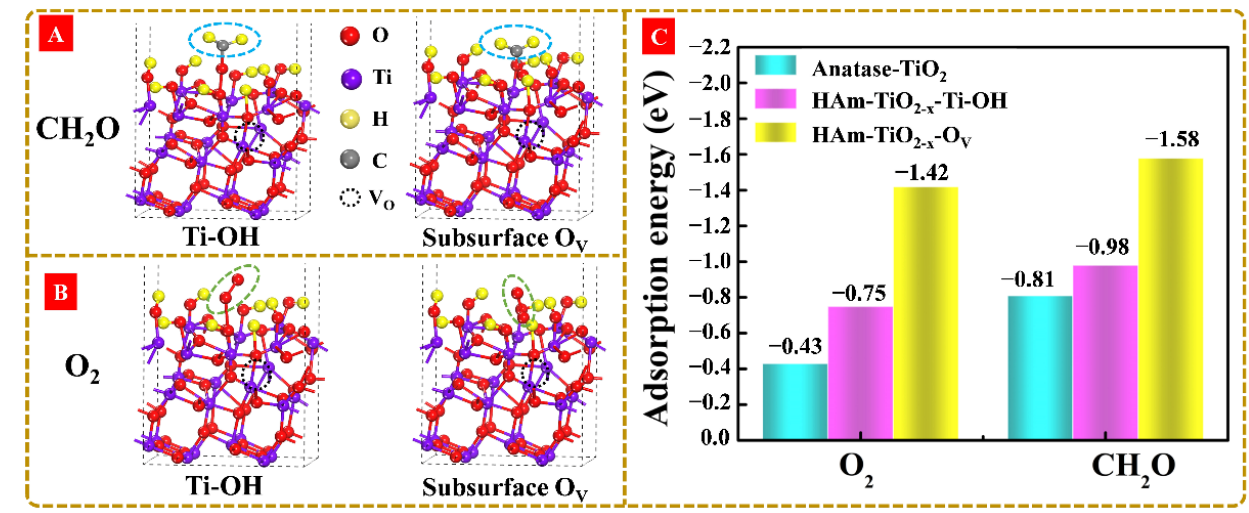
Figure 11. The adsorption models of ( A ) formaldehyde and ( B ) oxygen in the presence of surface hydroxyl groups and subsurface O V , respectively. ( C ) The adsorption energies of O 2 and HCHO over anatase TiO 2 , HAm-TiO 2 − x -OH, and HAm-TiO 2 − x -O V .